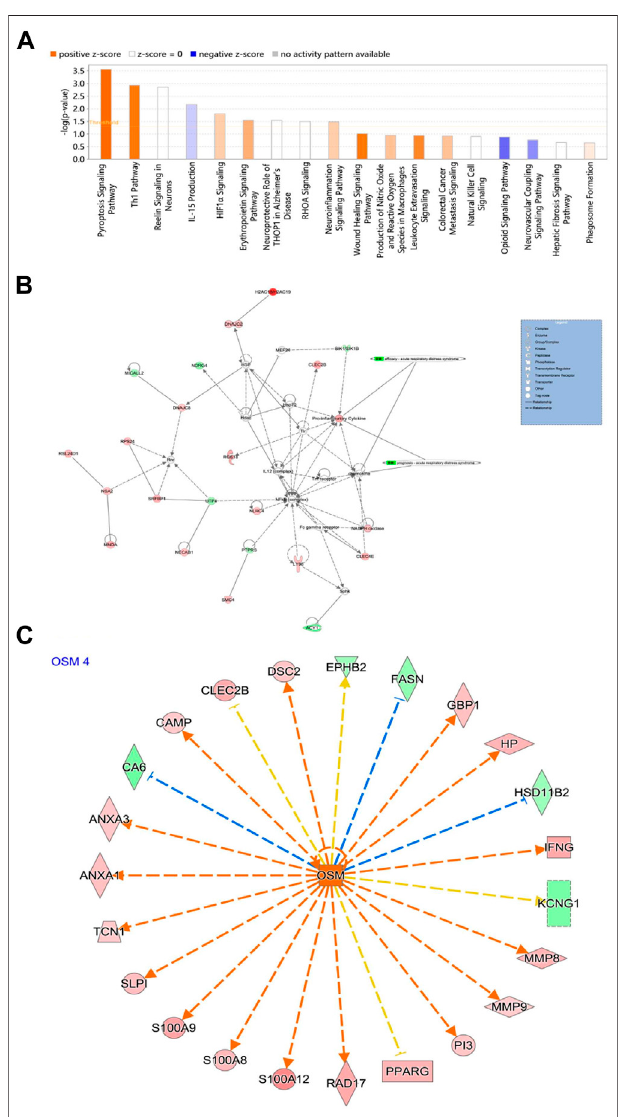
FIGURE 7 | (A) Signi fi cant classical pathway enrichment results; (B) IPA interaction network; (C) Regulation of activated OSM. Red represents upregulated genes, green represents downregulated genes, orange arrows represent the process of activation, blue represents the process of inhibition, and orange represents inconsistency with the results of the